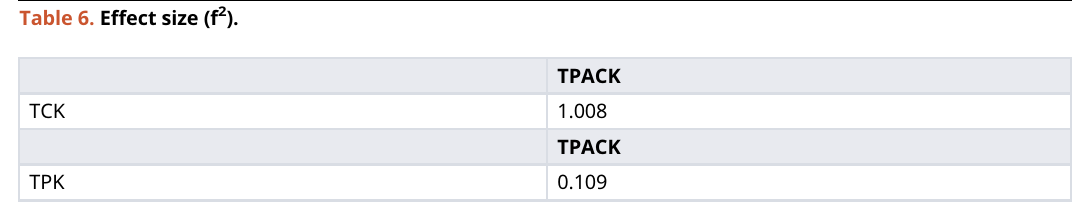
Table 6. Effect size (f 2